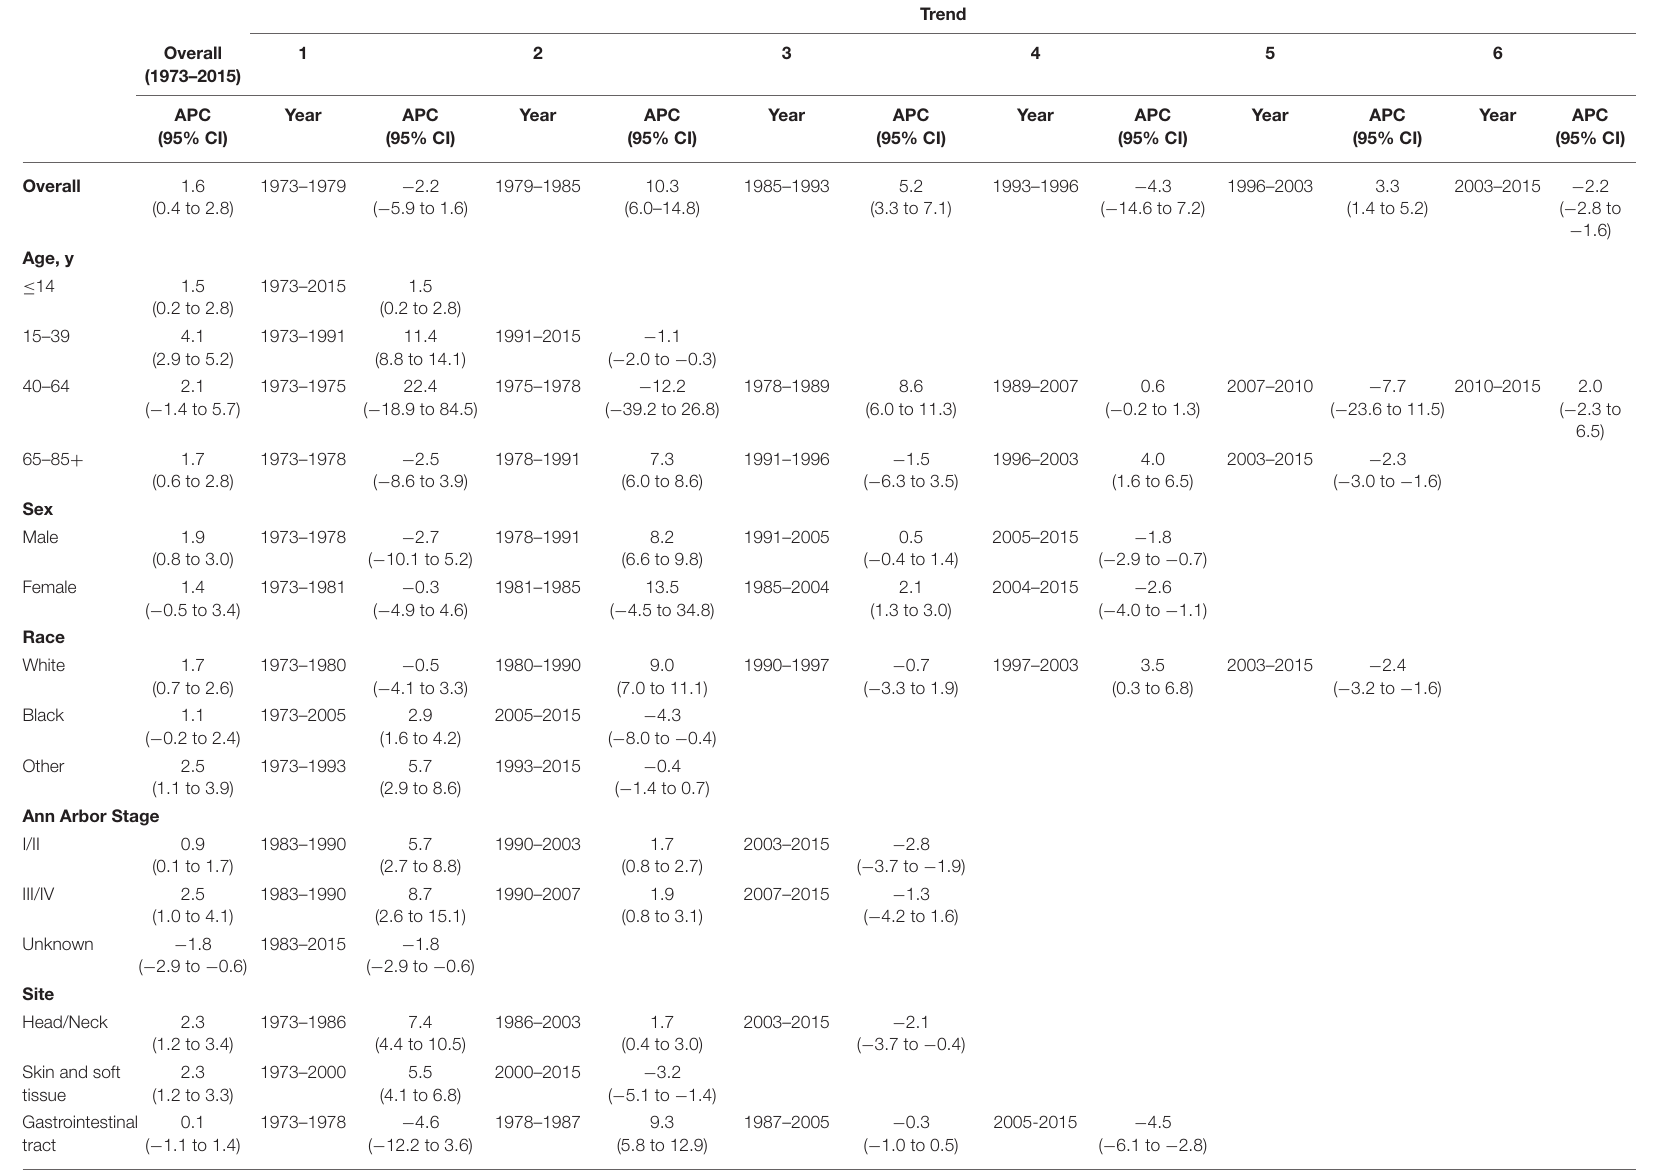
TABLE 2 | Trends in extranodal diffuse large B-cell lymphoma incidence rates (1973–2015): the SEER-9 registry